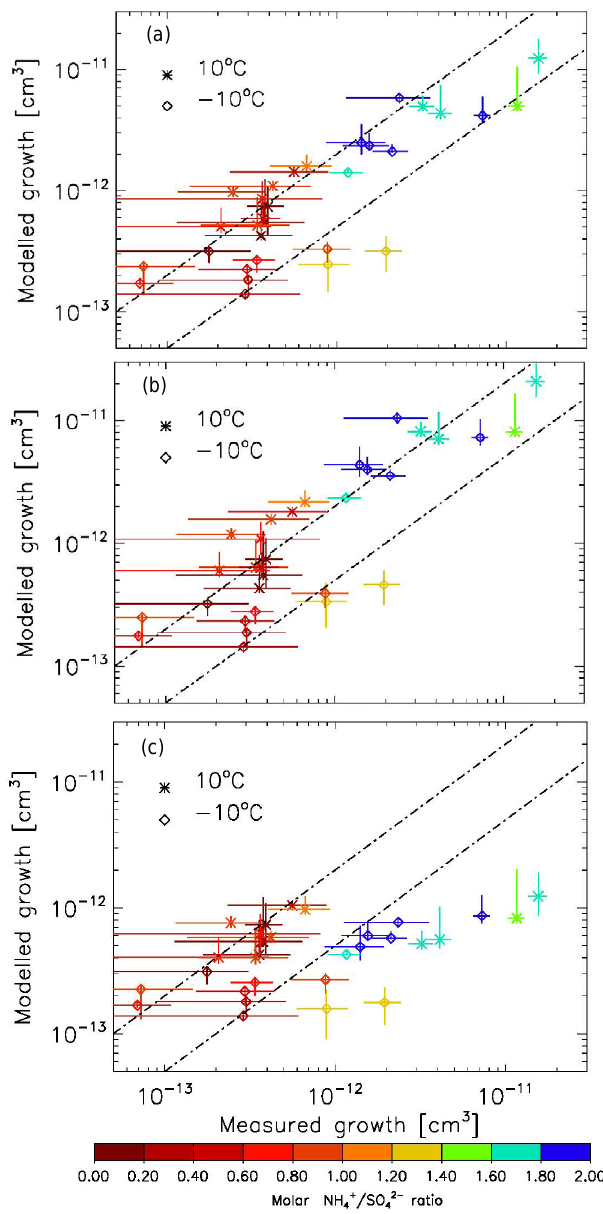
Figure 11. (a) The modelled vs. observed total increase in aerosol volume due to the aqueous phase oxidation of SO 2 to SO 2 − and − 10 ◦ C. Note that the masses are corrected to account for any particle loss during the expansion (see text). The dashed lines indi- cate the range of a factor of two higher or lower than the observed values. The error bars are as for Fig. 10. (b) As for (a) , but with doubled gas phase NH 3 . (c) As for (a) , but with no gas phase NH 3